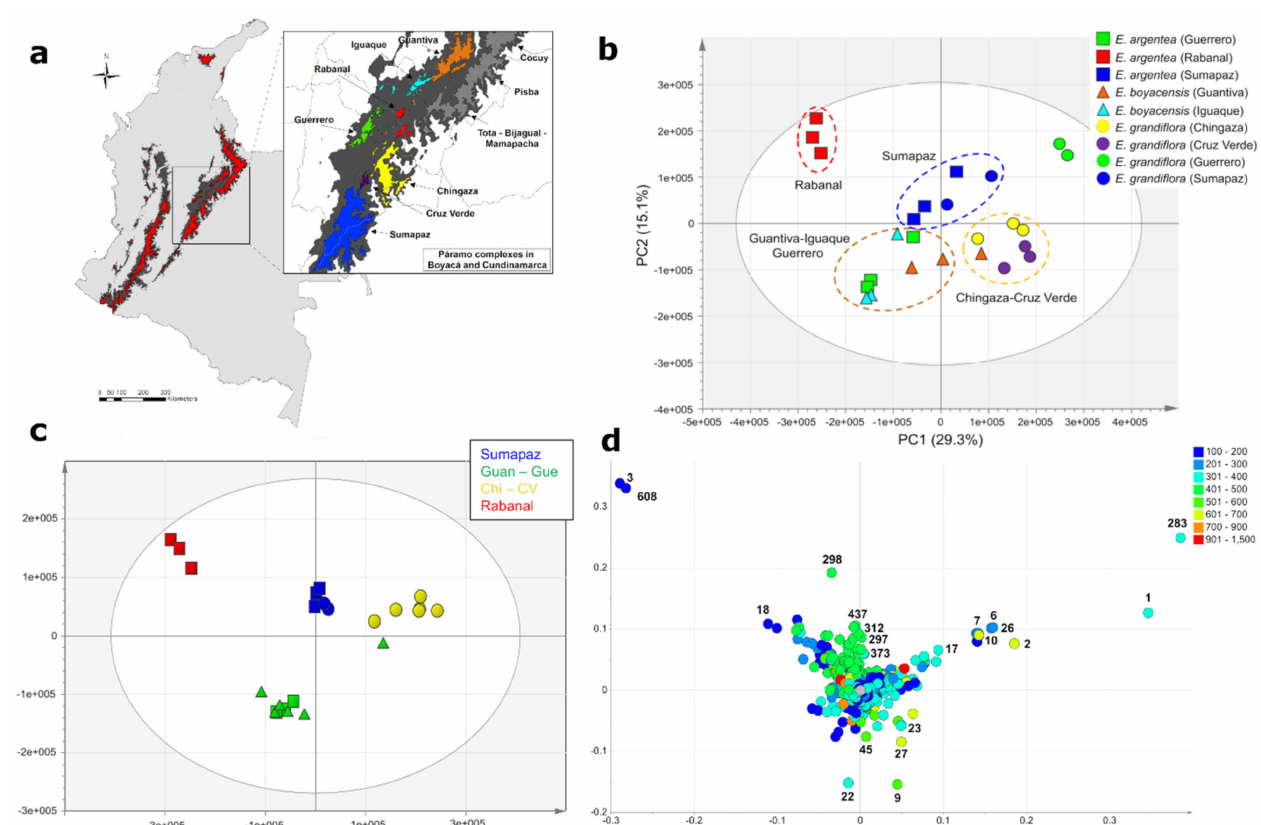
Figure 4. Clustering of 25 individuals from three species of Espeletia based on metabolic fingerprinting in negative ion mode (915 variables). ( a ) Map of Colombia with different p á ramo complexes within the Boyac á and Cundinamarca massifs highlighted in different colors. ( b ) PCA scores plot showing a clustering tendency according to p á ramo complexes. ( c ) orthogonal partial least squares discriminant analysis (OPLS-DA) ( R 2 = 0.96, Q 2 = 0.77) scores plot showing the correlation between metabolic fingerprints and p á ramo complexes of species from Sumapaz, Guantiva, Iguaque, and Guerrero (Guan– Gue), Chingaza and Cruz Verde (Chi–CV) and Rabanal. Species are represented by different symbols: squares ( E. argentea ), triangles ( E. boyacensis ), and circles ( E. grandiflora ). ( d ) OPLS-DA loadings plot. For compound identities, please refer to Table 3. Map created in the software ArcGIS